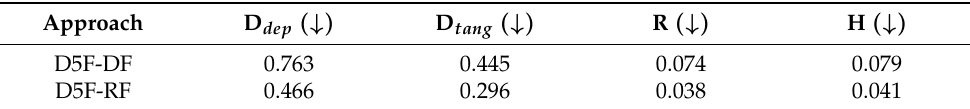
Table 5. MAE of radius ( R ), height ( H ), and location in depth ( D dep ) and tangential direction ( D tang ) of predicted cylinder. Errors are measured in